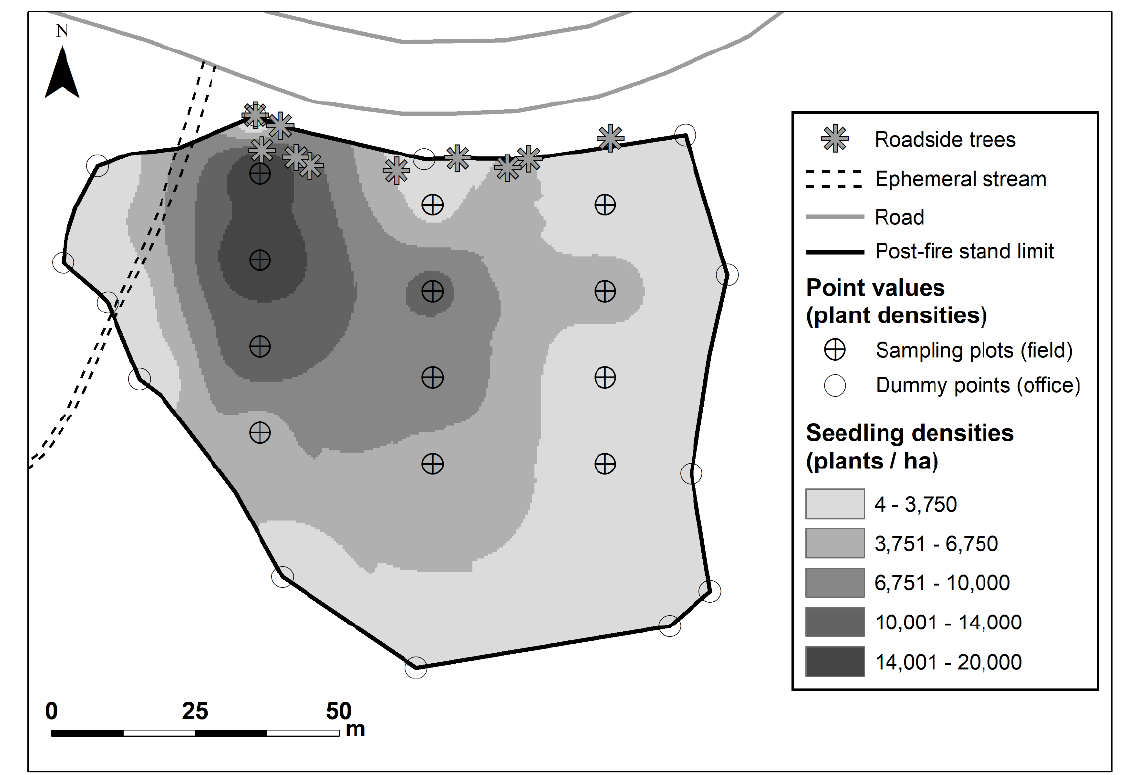
Figure 2. Spatial interpolation of seedling densities across the post-fire expansion area, based on 12 sampling plots. Dummy points were created on peripheral seedlings in the outer limits of the expansion area, and assigned a density of 1000 plants ha − 1 .